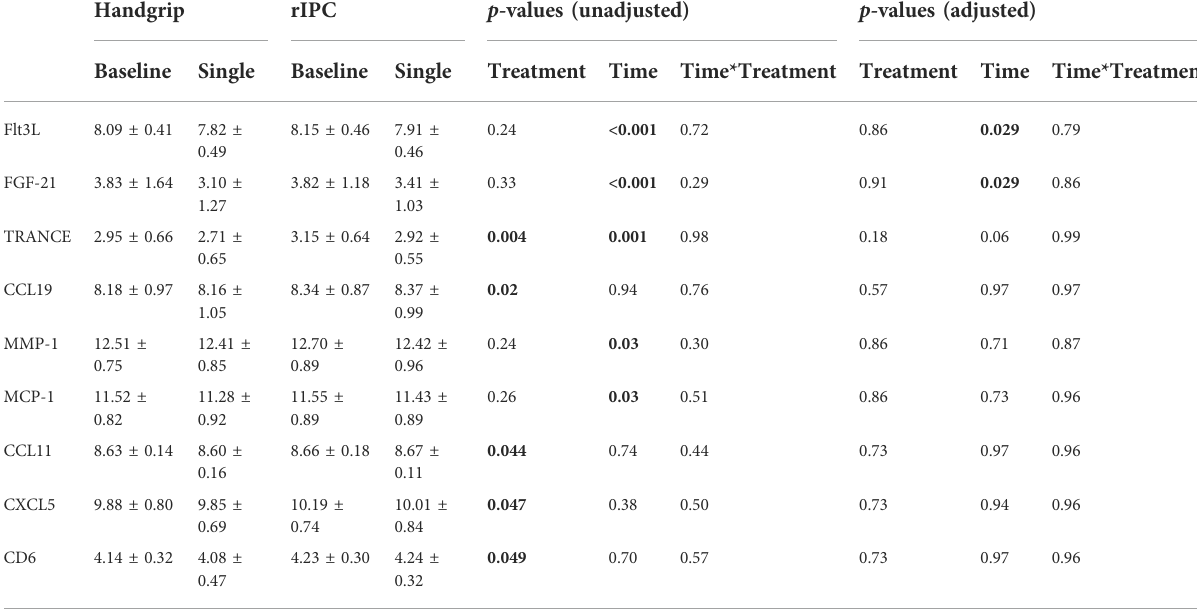
TABLE 2 Levels of in fl ammatory biomarkers before and after single preconditioning.